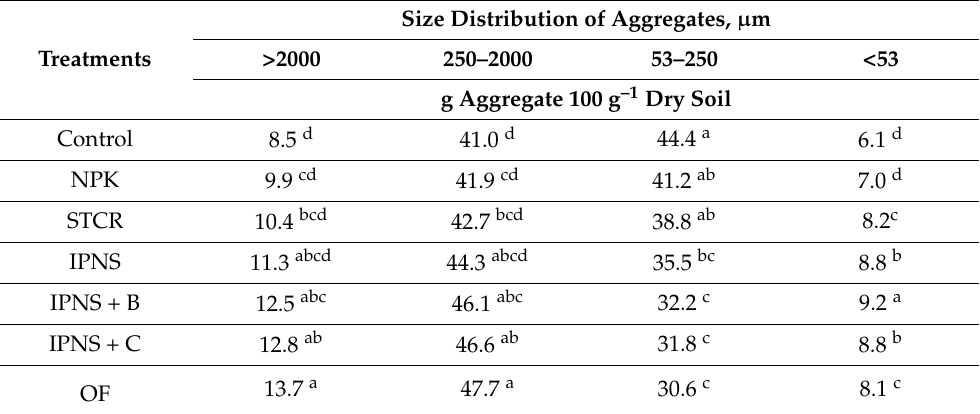
Table 3. Soil aggregation distribution as affected by long-term nutrient supply options of rice-wheat system in the 15–30 cm soil layer. Means of different treatments followed by the different lower-case letter are significantly different at p < 0.05 level of significance according to